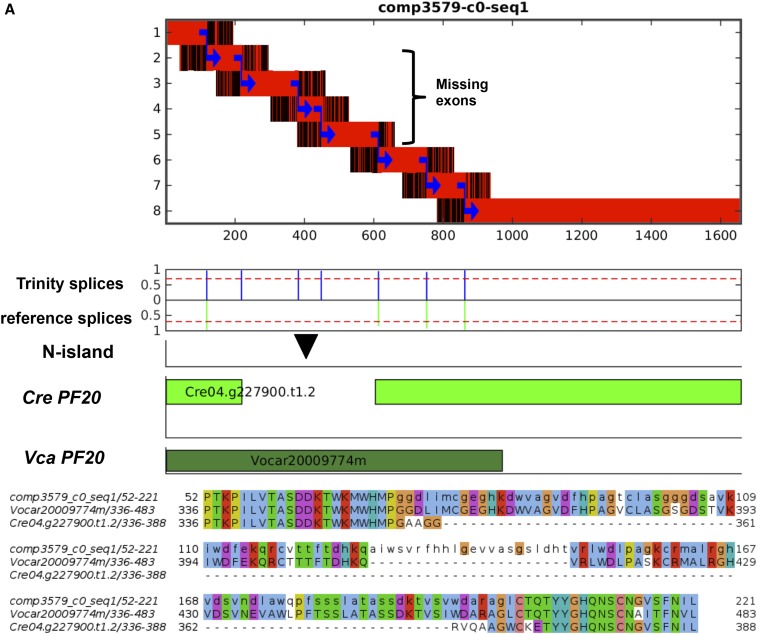
N-islands can contain hidden exons. Two examples are shown. (A) PF20; (B, C) CDC27. (A, B) Diagrams as in Figure 5. In both cases, one N-island contains hidden exons (four in PF20, two in CDC27). The second N-island in CDC27 is covered; the diagram shows it to be authentically intronic according to the Trinity object analysis. As in Figure 5, black bars indicate the approximate position of the intronic N-island in the Phytozome gene model. Multiple sequence alignments between Trinity and Phytozome peptide sequences from Chlamydomonas and Volvox were generated by clustalo (Sievers et al. 2011). (C) The analysis recovers splice-site-proximal intronic sequences; illustrated for CDC27. The islands from genomic reads, including Trinity nonhomologous sequence, align perfectly with reference genomic sequence for individual exons (green bars), and surrounding intronic sequence (green lines). Similar extensions (red lines) beyond the Trinity-aligned segments (red bars) are detected for the two hidden exons ‘E-X’ and ‘E-Y’. (D) These extensions are characterized by strong terminal splice site homology, which we take as evidence that ‘exons X and Y’ are in fact spliced into the mature CDC27 mRNA, as reflected in the Trinity object comp4349-c0-seq1.